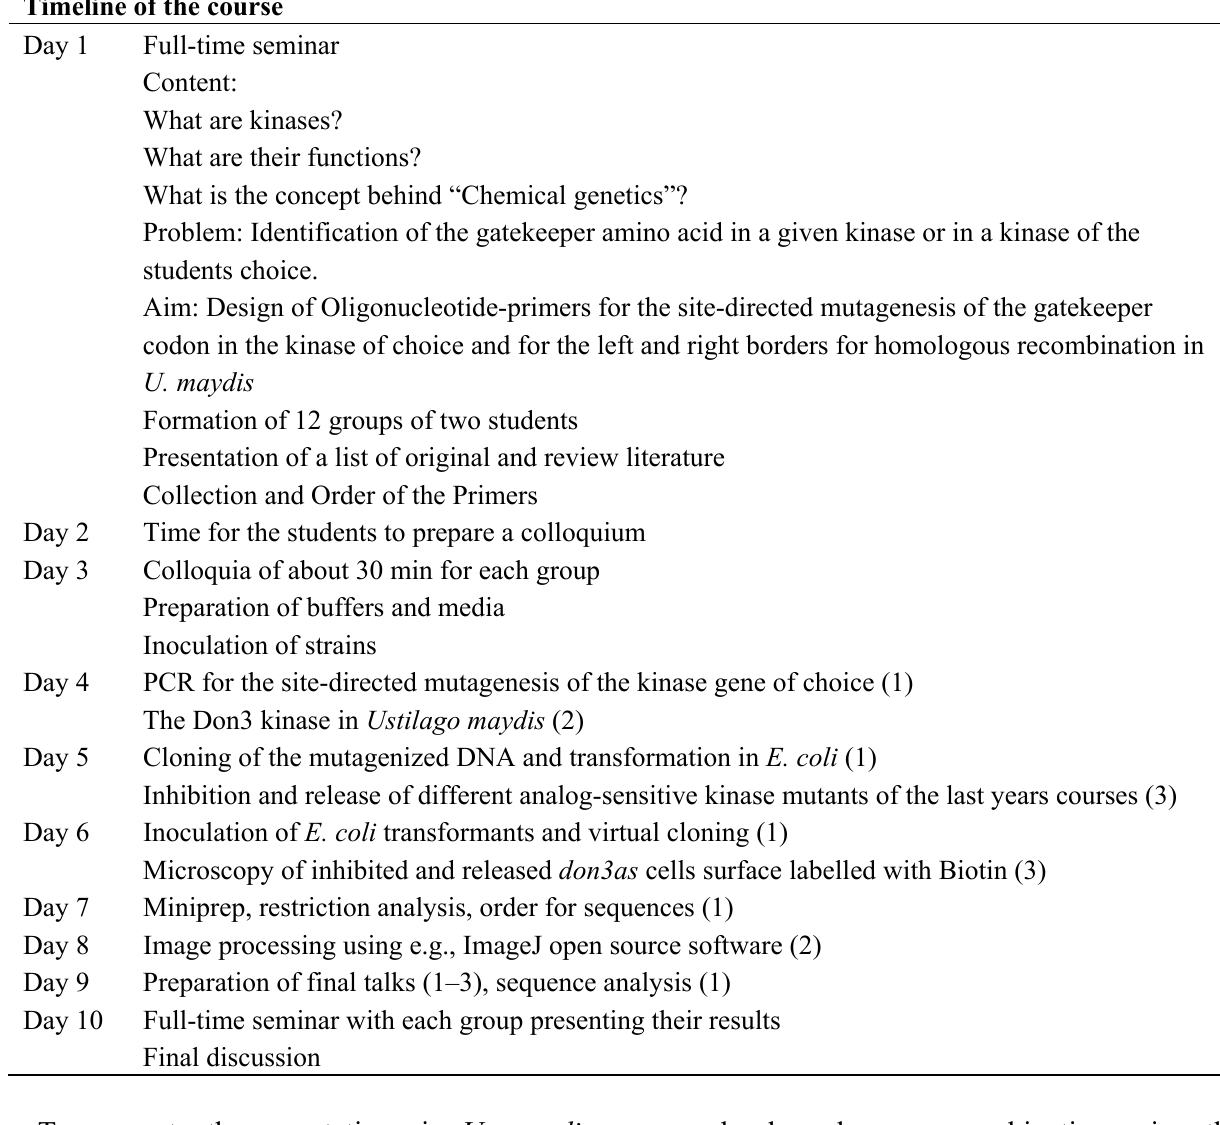
Table 1. Structural organisation of the course “Chemical